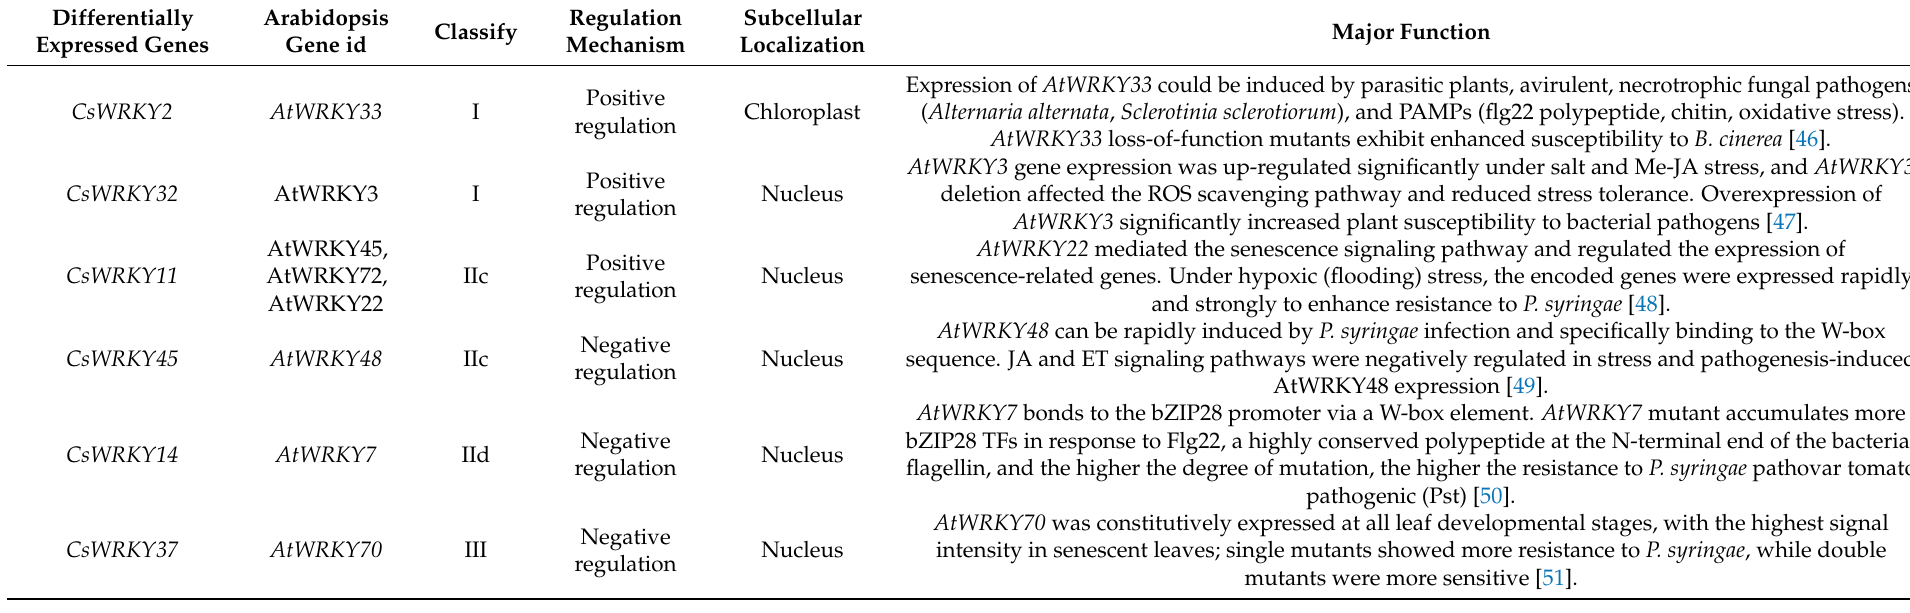
Table 2. The functional inference of CsWRKY genes differentially expressed in sweet